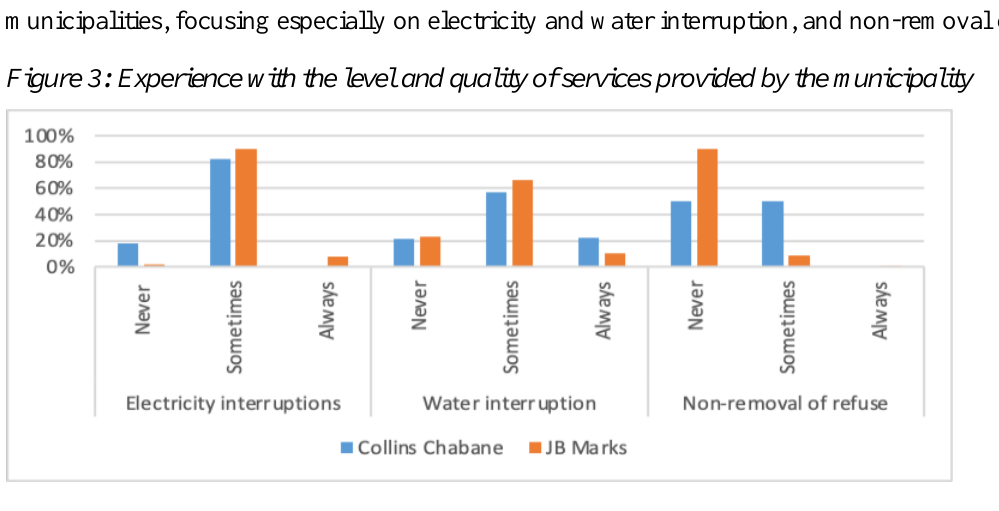
A high proportion of participants (90%) in JB Marks claimed that they “sometimes” experienced electricity interruptions, while 65% claimed that they “sometimes” experienced water interruptions. While 90% of the participants in JB Marks indicated that they have “never” experienced